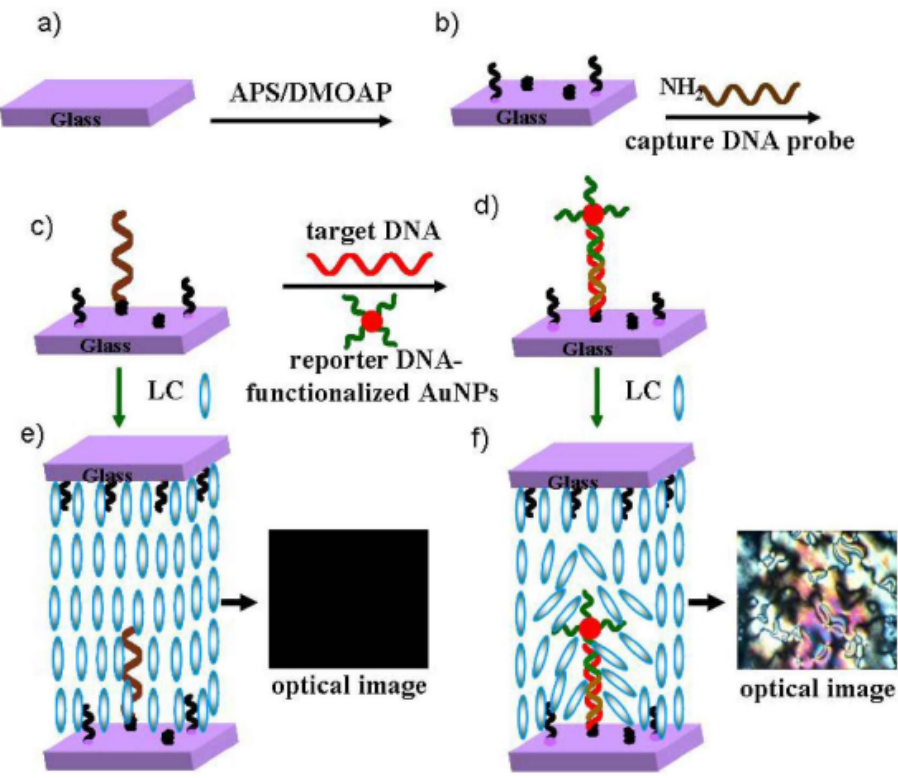
Figure 7. Principle of of LC biosensor based on gold nanoparticles signal enhancement. ( a ) cleaned glass slide; ( b ) assembled APS / DMOAP substrate; ( c ) fixed capture DNA probe substrate; ( d ) occurrence of binding events; ( e ) optical image of LC sensing cell before binding events; ( f ) optical image of LC sensing cell after binding events, disruption of the homeotropic LCs [28].